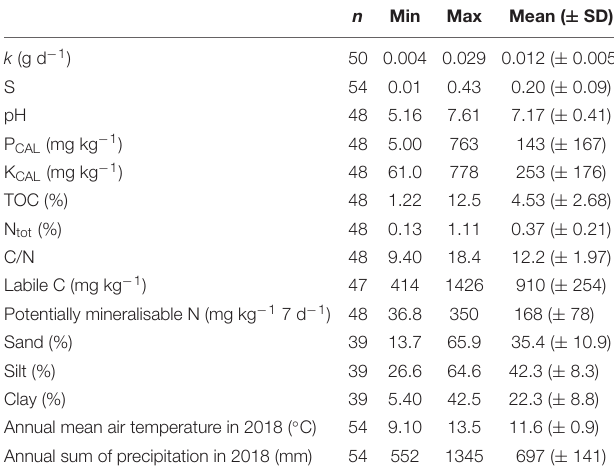
TABLE 1 | Summary of results for the Tea Bag Index, i.e., decomposition rate ( k ) and stabilization factor (S), soil and environmental characteristics for the sites investigated in TeaTime4Schools, presented as minimum, maximum and mean ( ± standard